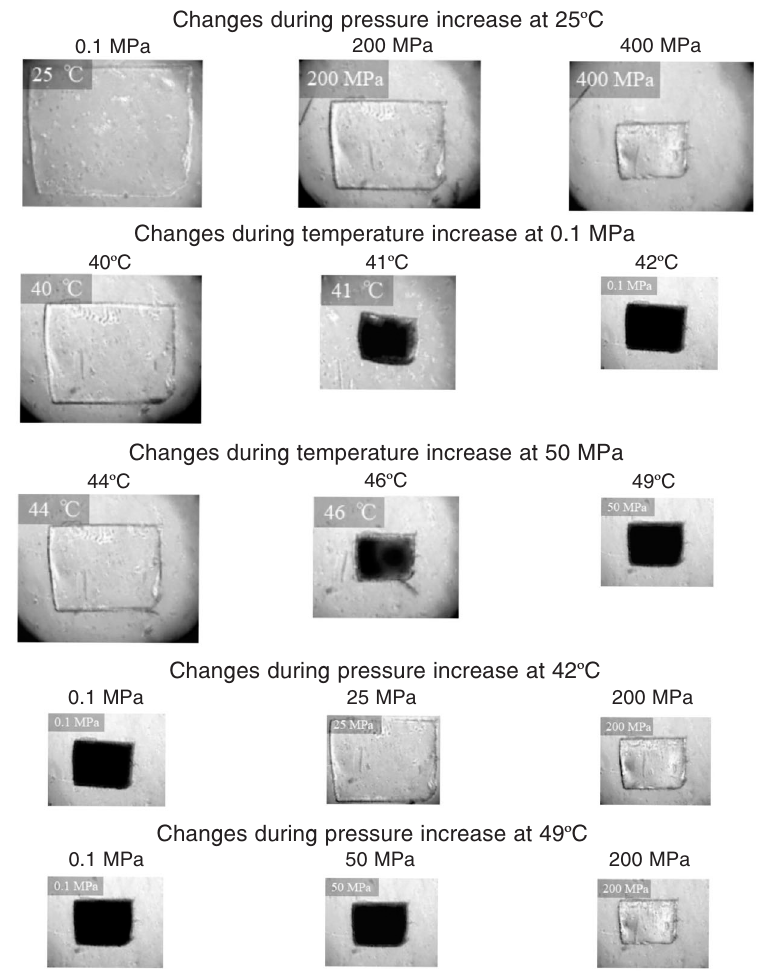
Figure 4. Some examples of microscopic images of the cross-linked poly(N-vinyliso- butyramide) (pNVIBA) gels under various conditions.